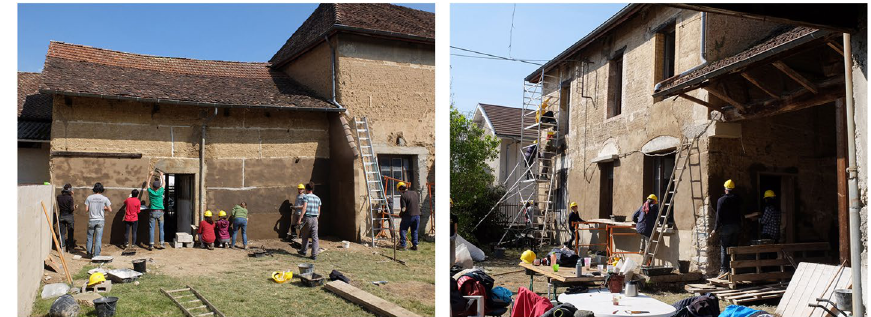
Fig. 4 Postgraduate conservation training for young professionals from 15 countries who came to Grenoble in 2021 to specialise in earthen architecture conservation (Source: the